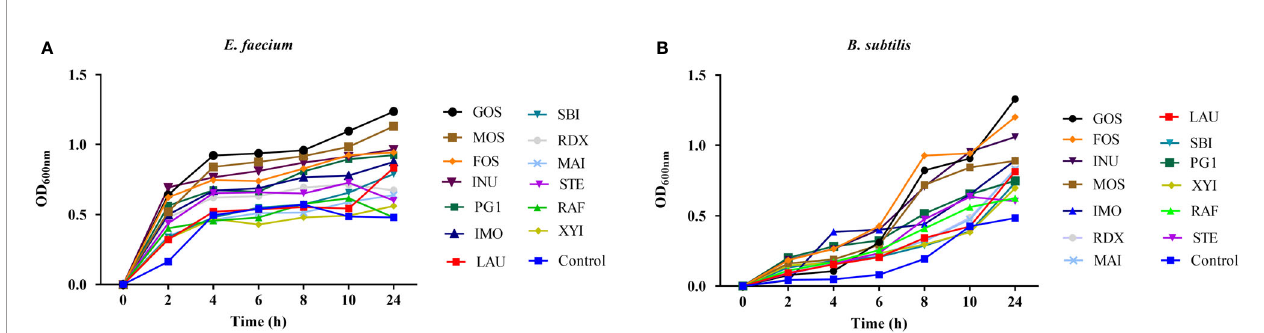
FIGURE 1 | Growth kinetics of Enterococcus faecium (A) and Bacillus subtilis (B) when cultured with different oligosaccharides, as measured by optical density (OD) values during 24 h of an incubation period in batch fermentation. basal medium (YCFA), fruto-oligosaccharides (FOS), lactulose (LAU), raf fi nose (RAF), stachyose (STE), galacto-oligosaccharides (GOS), mannose-oligosaccharides (MOS), isomalto-oligosaccharide (IMO), inulin (INU), polyglucan type 1 (PG1), xylitol (XYI), sorbitol (SBI), mannitol (MAI), resistance dextrin